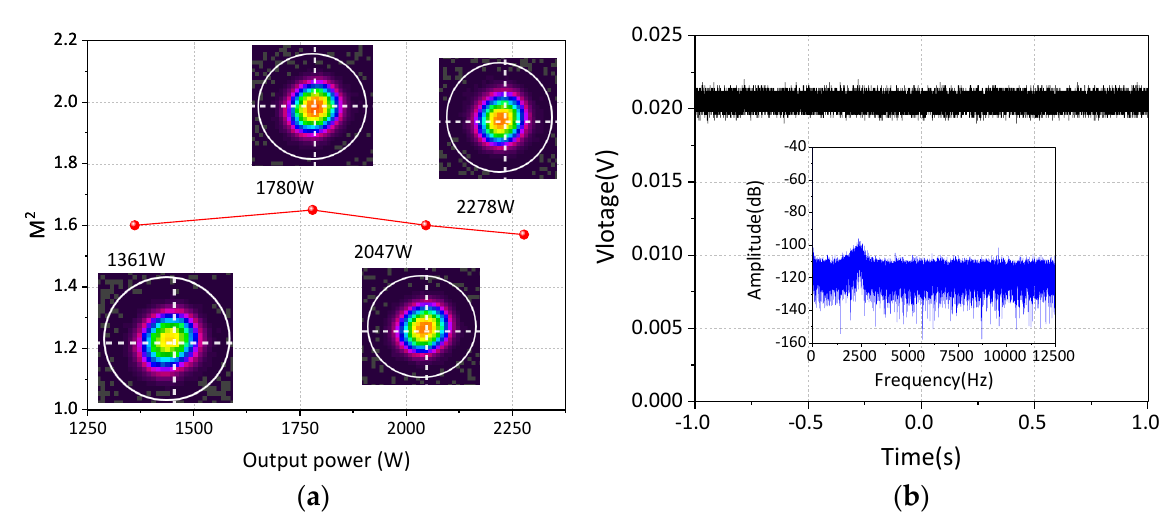
Figure 4. ( a ) The beam quality at several output power. ( b ) Temporal signals and corresponding Fourier spectra at the output power of 2278 W.